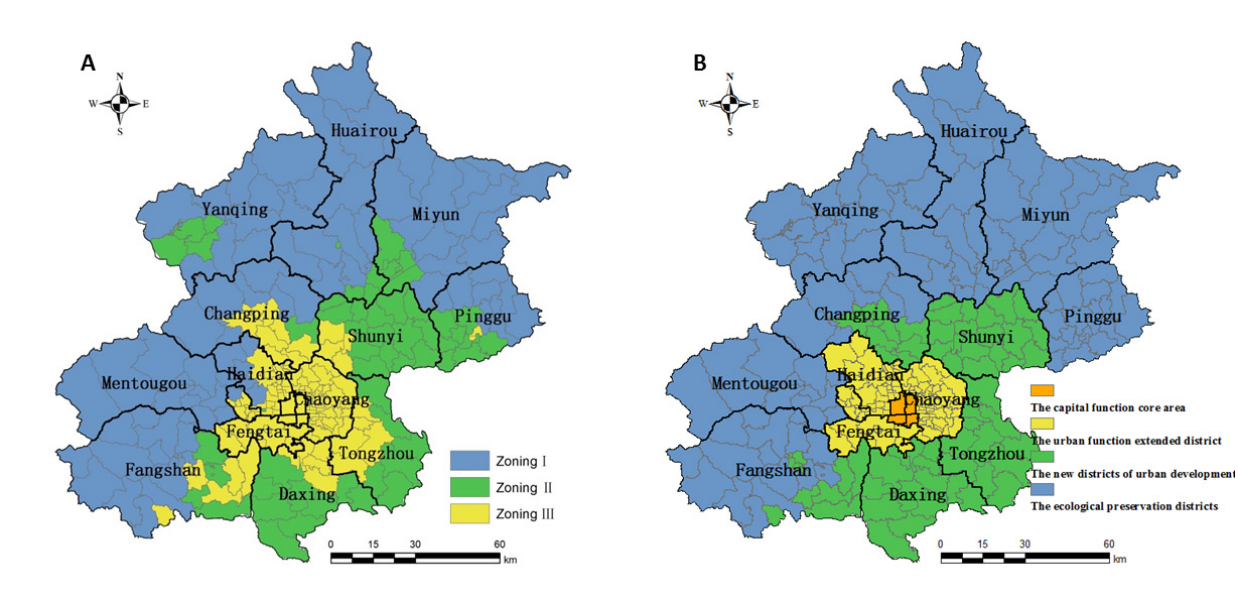
Figure 8. ( A ) Further presentation of clustering results and ( B ) Major function oriented zone of